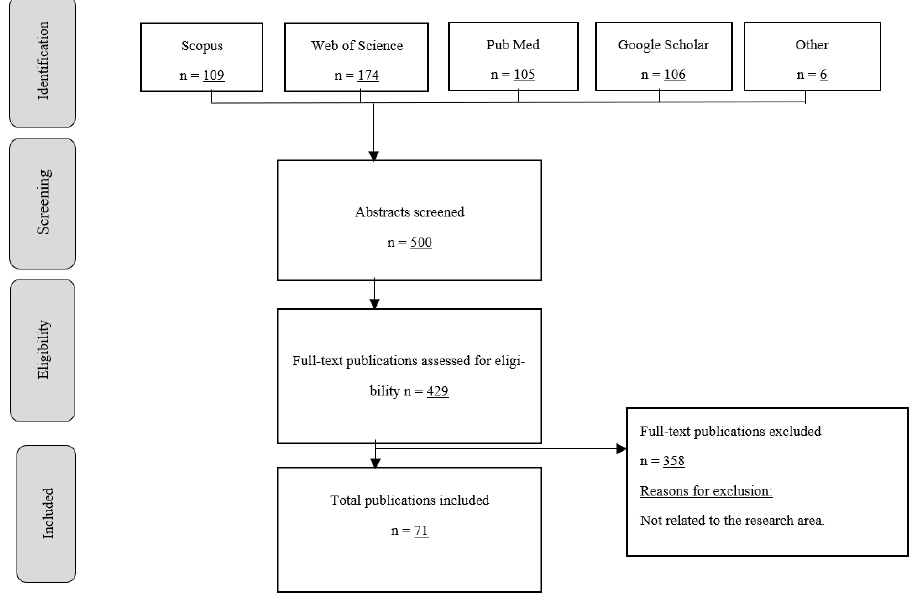
Figure 1. Classification process.